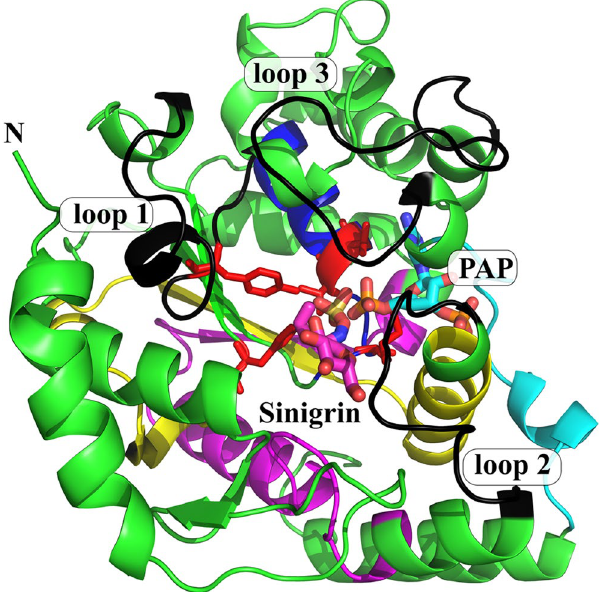
Figure 3. Overall view of AtSOT18 from two perspectives bound with sinigrin (magenta sticks) and PAP (cyan sticks). Indicated are the four conserved regions (region I: blue; region II: yellow; region III: magenta: region IV: cyan), the three flexible loop regions (black), the catalytic residues (red) and proline 136 (orange). The upper view shows the three flexible loops gating the sinigrin binding site. The view below shows how two of the four typical β -strands are formed by the conserved regions II and